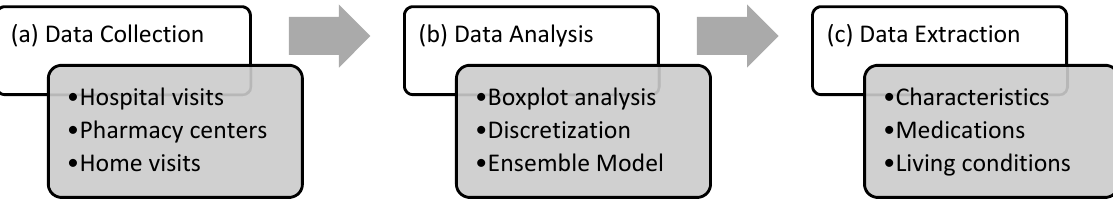
Figure 1. Three stages of the knowledge extraction process employed in the research.